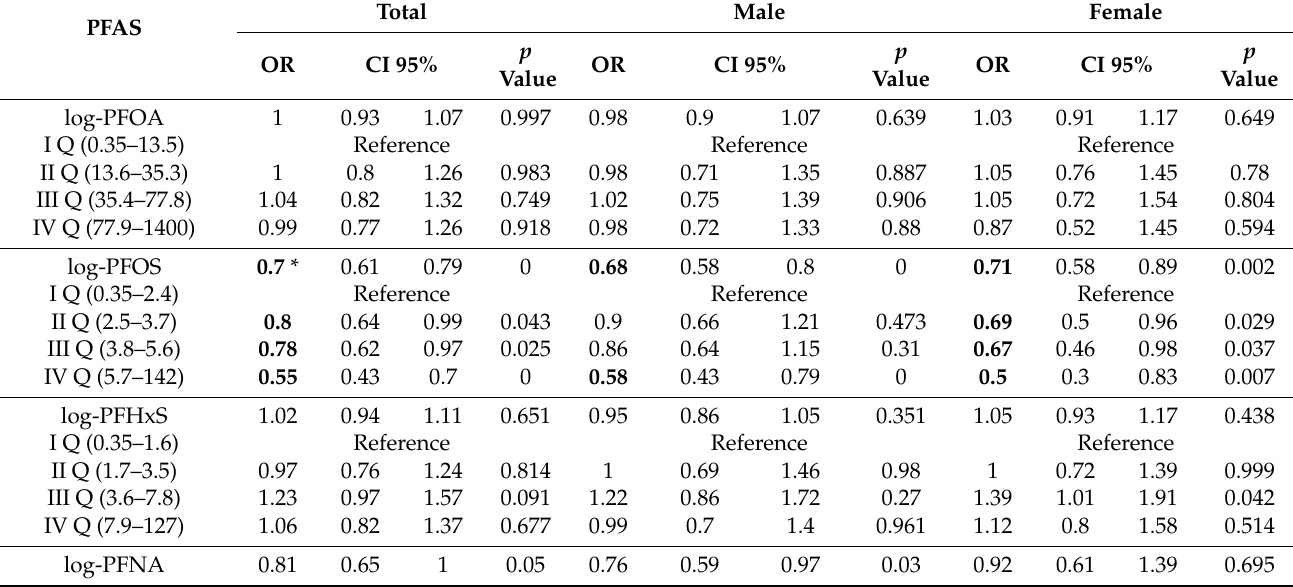
Table 3. Generalized Additive Models (GAM) models for the association between perfluoroalkyl substances (PFAS) (ln µ g/L) and metabolic syndrome (MetS), stratified by gender, adjusted by several covariates a , using the continuous and PFAS